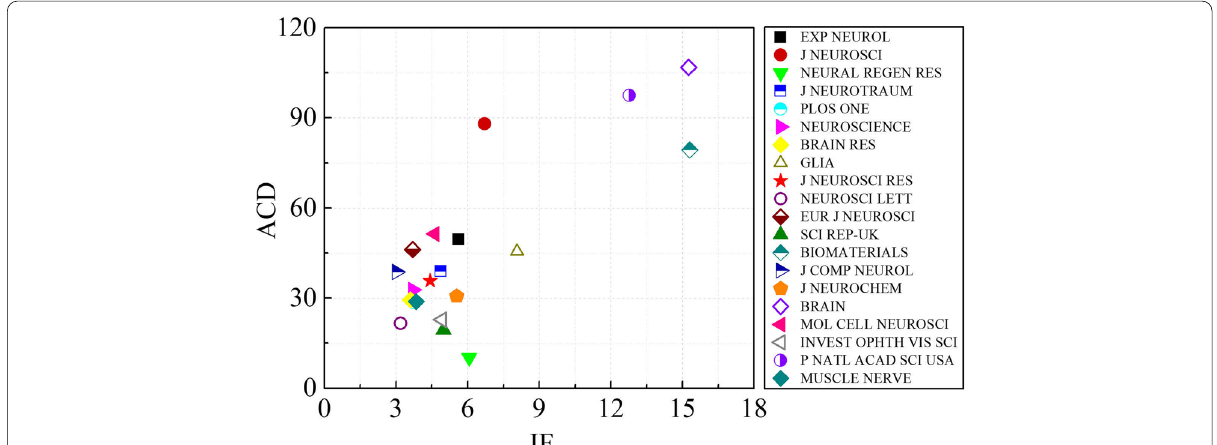
Fig. 3 The impact evaluation of the leading journals. IF, impact factor; ACD the average number of citations per document. EXP NEUROL, Experimental Neurology ; J NEUROSCI, Journal of Neuroscience ; NEURAL REGEN RES, Neural Regeneration Research ; J NEUROTRAUM, Journal of Neurotrauma ; BRAIN RES, Brain Research, J NEUROSCI RES: Journal Of Neuroscience Research, NEUROSCI LETT: Neuroscience Letters, EUR J NEUROSCI: European Journal Of Neuroscience, SCI REP-UK: Scientific Reports, J COMP NEUROL: Journal Of Comparative Neurology, J NEUROCHEM: Journal Of Neurochemistry, MOL CELL NEUROSCI: Molecular And Cellular Neuroscience, INVEST OPHTH VIS SCI: Investigative Ophthalmology Visual Science, P NATL ACAD SCI USA: Proceedings Of The National Academy Of Sciences Of The United States Of